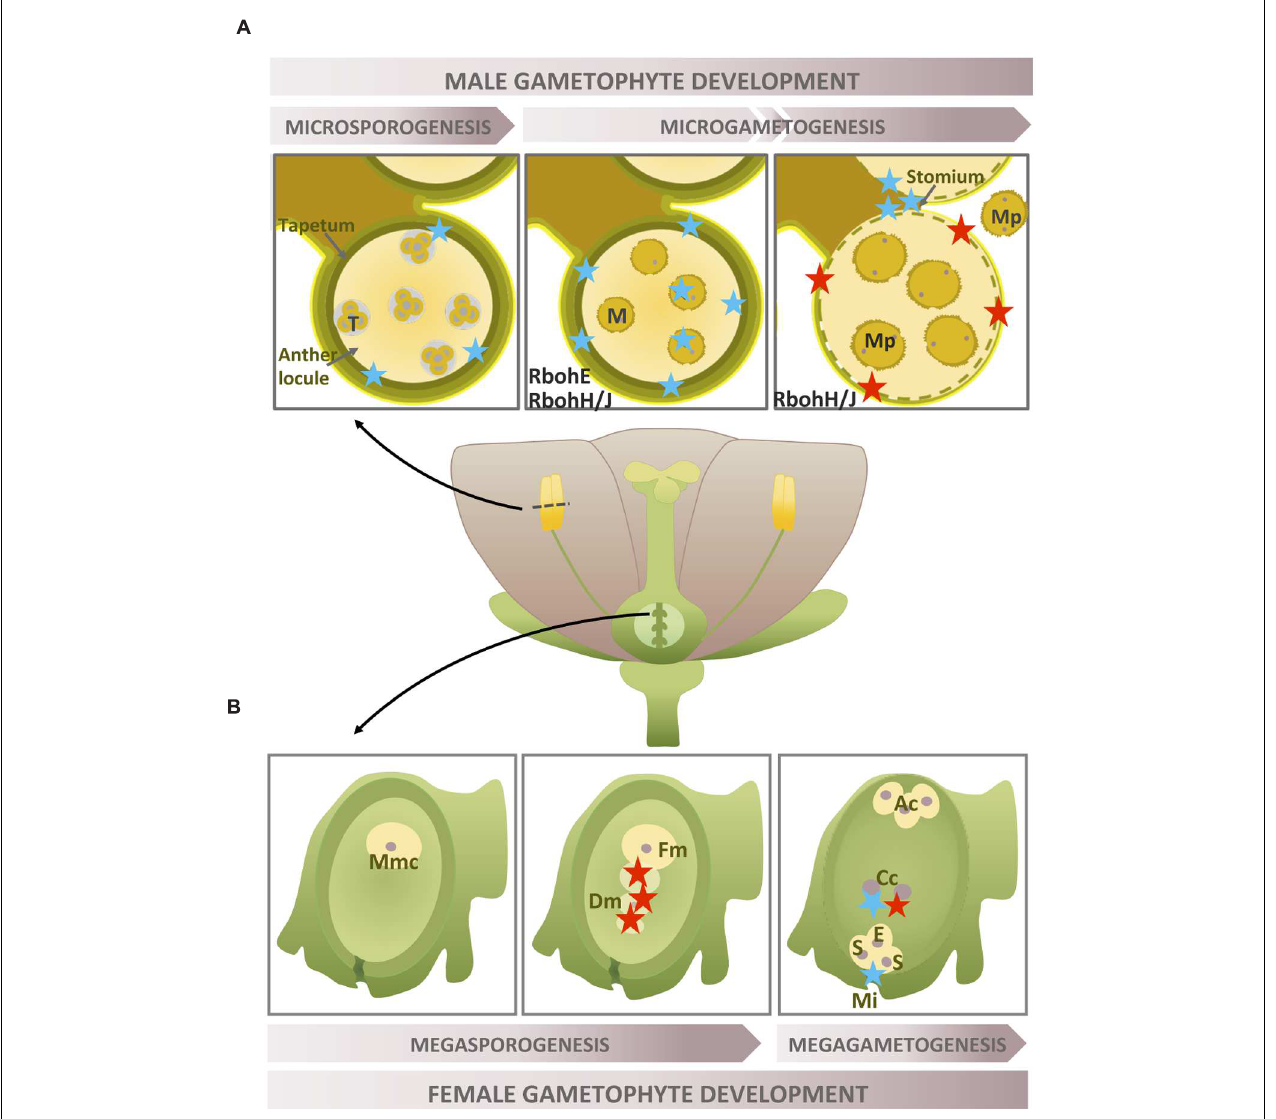
FIGURE 1 | Rboh-dependent superoxide production during gametophyte development. Location of O •− 2 during the development of gametophytes. (A) Two selected stages of late anther development (tetrads and microspores) and anthers at the dehiscence stage. (B) Three selected female gametophyte development stages, including the pre-meiotic phase, functional megaspore formation and the fully developed embryo sac stage. The localization of H 2 O 2 accumulation is also shown when necessary (for more detailed information, see text above). Recognized sources of superoxide are marked in black. Blue star: O •− 2 ; red star: H 2 O 2 ; T, tetrads; M, microspore; Mp, mature pollen; Mmc, megaspore mother cell; Fm, functional megaspore; Dm, degenerating megaspore; Ac, antipodal cell; Cc, central cell; S, synergid; E, egg cell; Mi,